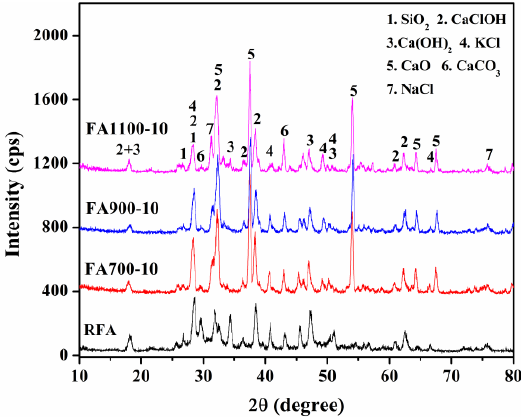
Figure 2. XRD spectra of raw fly ash (RFA) and thermally treated slags.